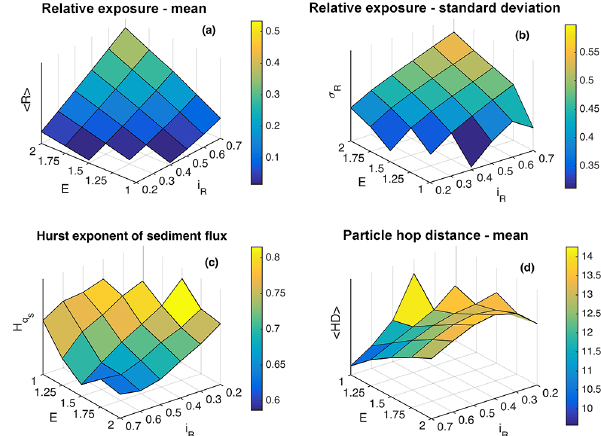
Figure 5. Selected CAST RBM variables as a function of input rate and entrainment: (a) mean relative exposure (cid:104) R (cid:105) , (b) standard de- viation of relative exposure σ R , (c) Hurst exponent of the specific sediment flux H q , and (d) mean particle hop distance (cid:104) HD (cid:105) . S